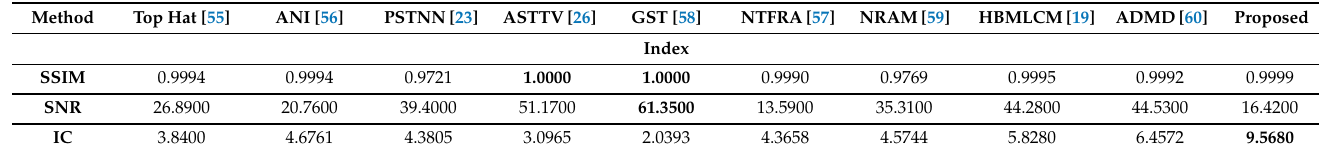
Table 7. Calculation of indicators in scenario C of each model.